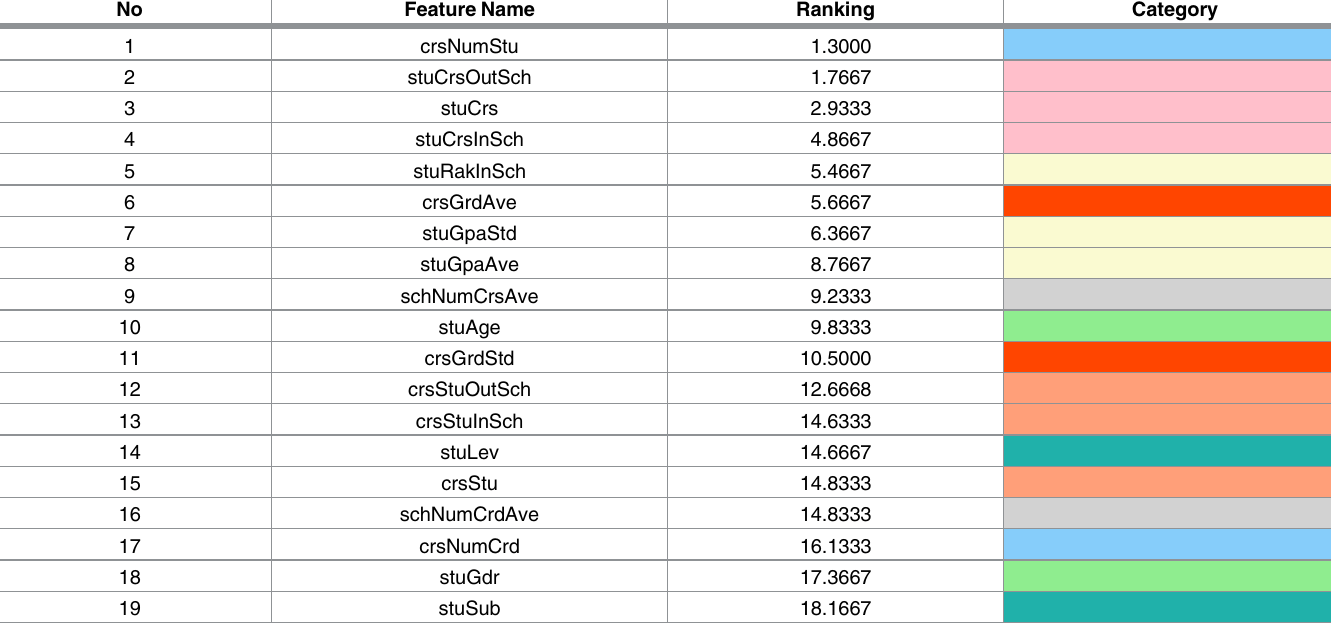
of each FIM on each row. After that, we can average the rankings for all the features on the whole, as listed in Table 8. From this table, it can be observed that the orders of features are almost the same as those in Fig 8, which means that the conclusions drawn by Figs 8 and 9 are sustained. Although for the course preference, its corresponding features have high variance, at 95% confidence level, they still occupy the positions from the 2 nd to 4 th . And except for crsNumStu , the three features in the course preference have higher rankings than the rest. In Table 8. Friedman rankings for all the